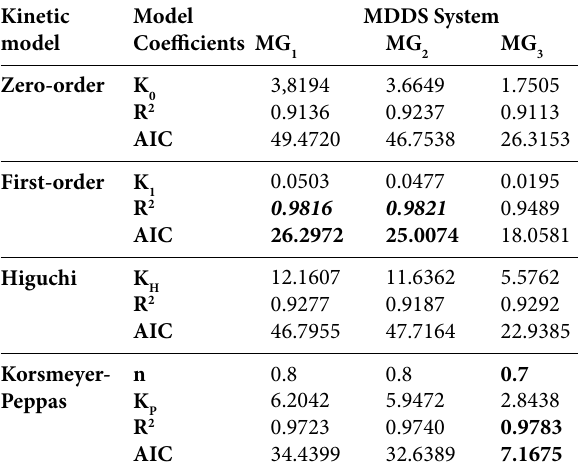
Table 2. Results of curve fitting of the in vitro BXT release profile from DDS silica based. Kinetic Model MDDS System